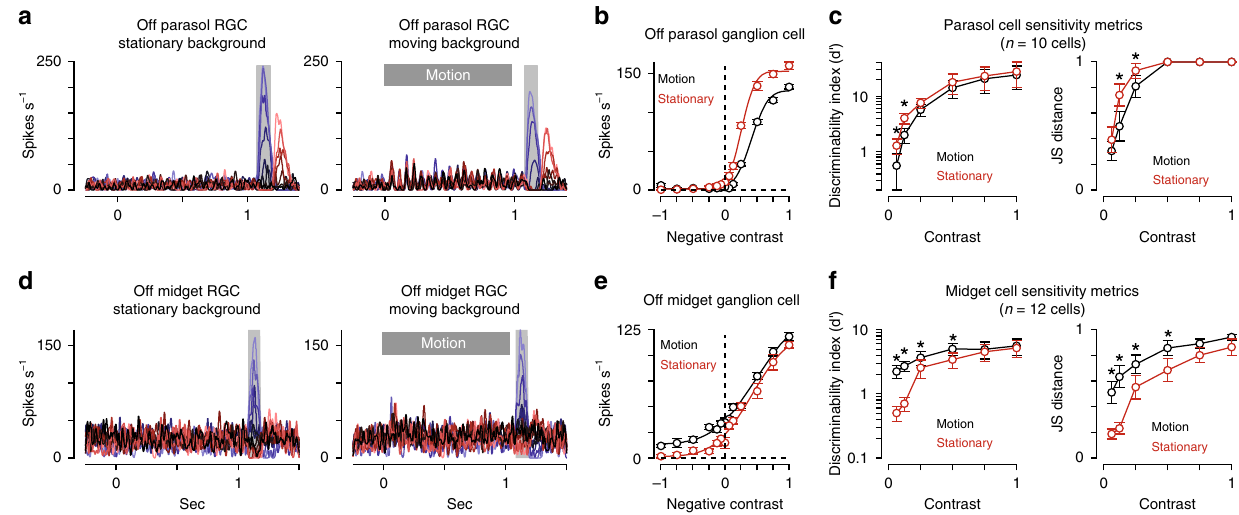
Fig. 10 Background motion evokes adaptation in parasol cells and sensitization in midget cells. a Averages spike rate as a function of time for an Off parasol ganglion cell a stationary texture followed by a series of test fl ashes centered over the cell ’ s receptive fi eld (left) or following the offset of texture motion (right; speed, 11 degrees s – 1 ). b Contrast-response functions for the cell in ( a ) for the measurements with a stationary texture (red) or a moving texture (black). c Sensitivity metrics for this experiment across 10 parasol cells. d Spike responses from an Off midget ganglion cell to the same experimental protocol. e Average spike rate across the shaded regions indicated in ( d ). The wide- fi eld adaptation evoked a leftward shift in the contrast-response curve (black) relative to the unadapted control condition (red). f Sensitivity values for the motion experiment across 12 midget cells. Motion produced a signi fi cant increase in sensitivity at low contrast relative to the stationary condition (contrast, ≤ 50%; p < 0.05; Wilcoxon signed rank test). Circles and bars indicate mean ±